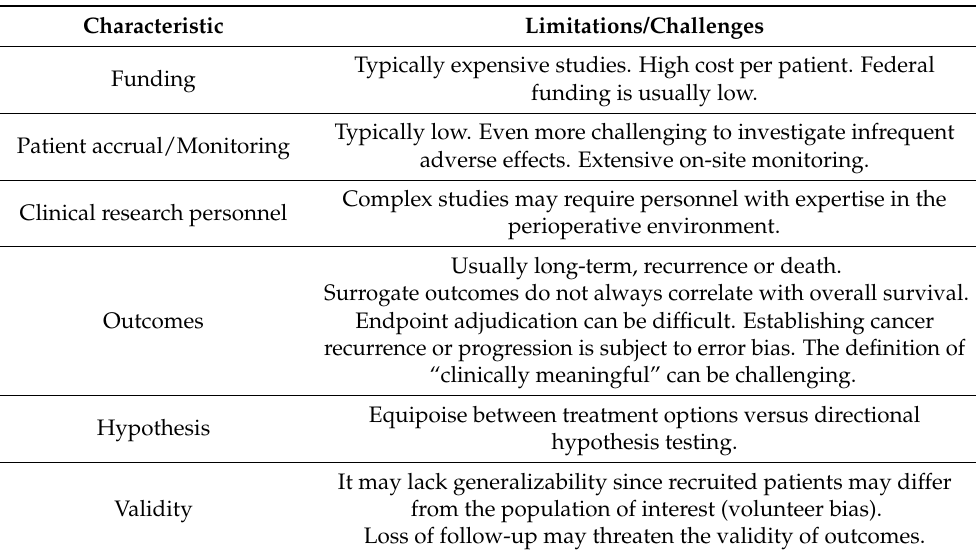
Table 2. Challenges and limitations of prospective